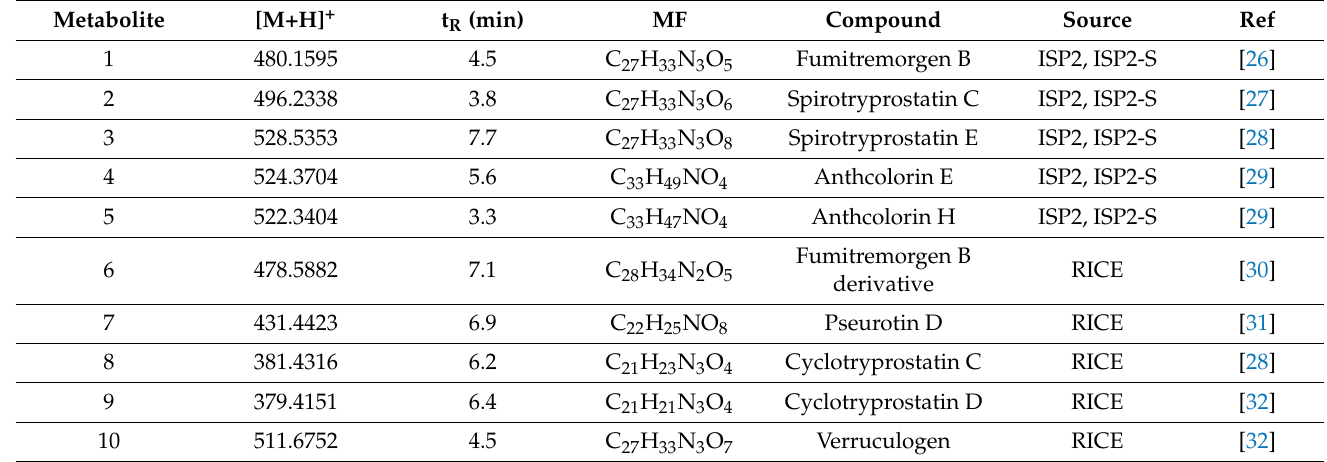
Table 1. Significant differential metabolites identified ( p -value < 0.05